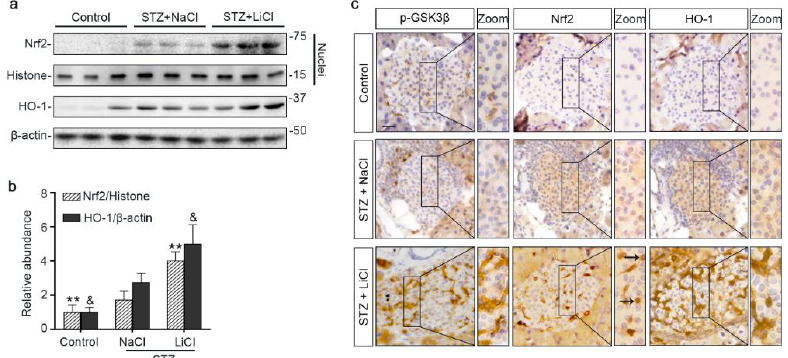
Figure 4. Microdose lithium therapy potentiates the Nrf2 antioxidant response to STZ injury in pancreatic islets. Animals were treated as elaborated in Figure 1. ( a ) Nuclear fractions of isolated islets were prepared, and together with whole islet homogenates, were processed for immunoblot analysis for indicated molecules. Representative immunoblots are shown. ( b ) Graphic presentation shows densitometric analyses of the abundance of Nrf2 in islet nuclei and the abundance of heme oxygenase (HO)-1 in islets, presented as relative levels normalized to histone and β-actin respectively. Data were expressed as fold changes over control and presented as mean ± SD; ** p < 0.01 versus STZ + NaCl; & p < 0.05 versus STZ + NaCl ( n = 5). ( c ) Formalin-fixed, paraffin-embedded pancreas sections were subjected to peroxidase immunohistochemistry staining for p-GSK3β (S9) , Nrf2 and HO-1, and representative micrographs indicate that the Nrf2 antioxidant response was enhanced in islets and largely located to the nuclei in the STZ + LiCl group, as indicated by arrows. Scale bar = 20 µm. Abbreviations: HO-1, heme oxygenase 1; Nrf2, nuclear factor erythroid 2-related factor 2; p-GSK3β, phosphorylated GSK3β at serine 9. 3.5. Nrf2 Activity is Required for the Lithium Reinforced Antioxidant Response to STZ Injury in Pancreatic Islets Lithium is known to affect a myriad of cellular signaling pathways, although GSK3β has been identified to be a major molecular target. To determine if the lithium promoted Nrf2 activity subsequent to GSK3β inhibition plays a major role in mediating the